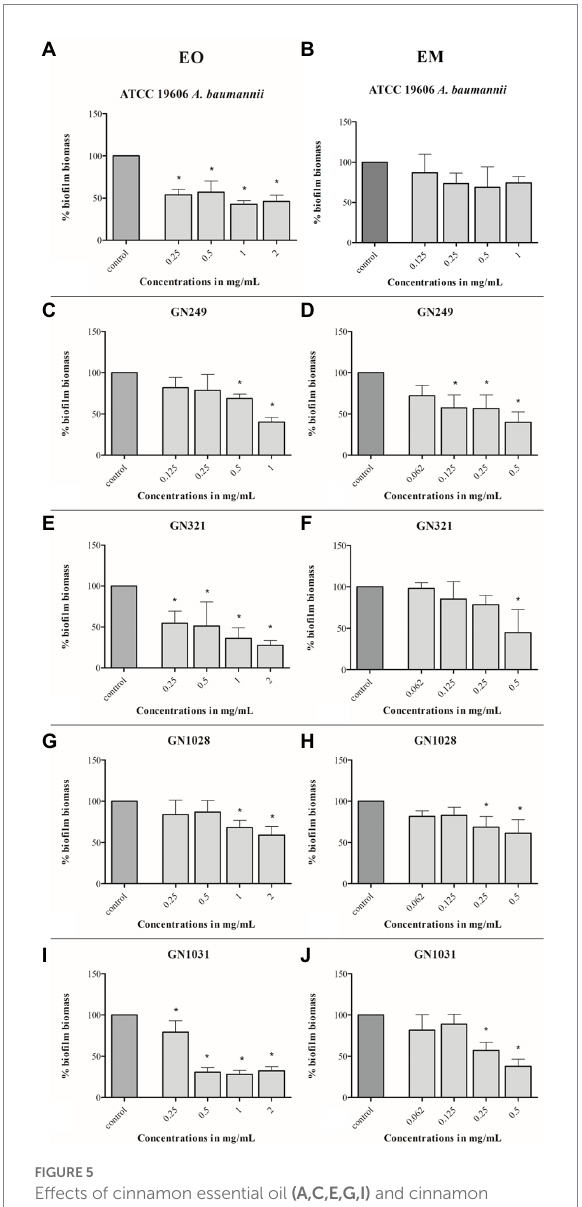
FIGURE 5 Effects of cinnamon essential oil (A,C,E,G,I) and cinnamon emulsion (B,D,F,H,J) on already formed biofilm of Acinetobacter baumannii strains. The share of pure cinnamon essential oil in emulsion was 20% v / v . The range of minimal inhibitory concentration values for cinnamon essential oil were from 0.25 to 0.5 mg/ml and for cinnamon emulsion from 0.125 to 0.25 mg/ ml. The experiment was done three times in hexaplicates. Statistical significance was * p <